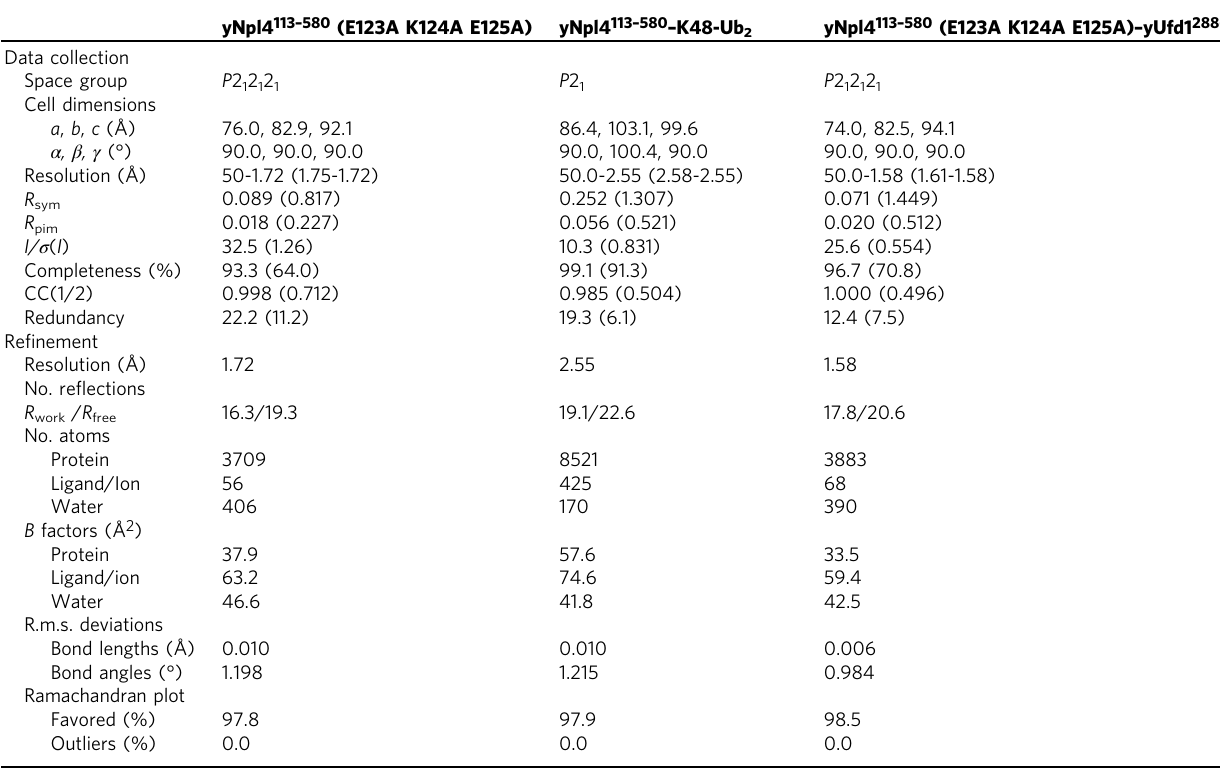
Table 1 Data collection and re fi nement statistics.